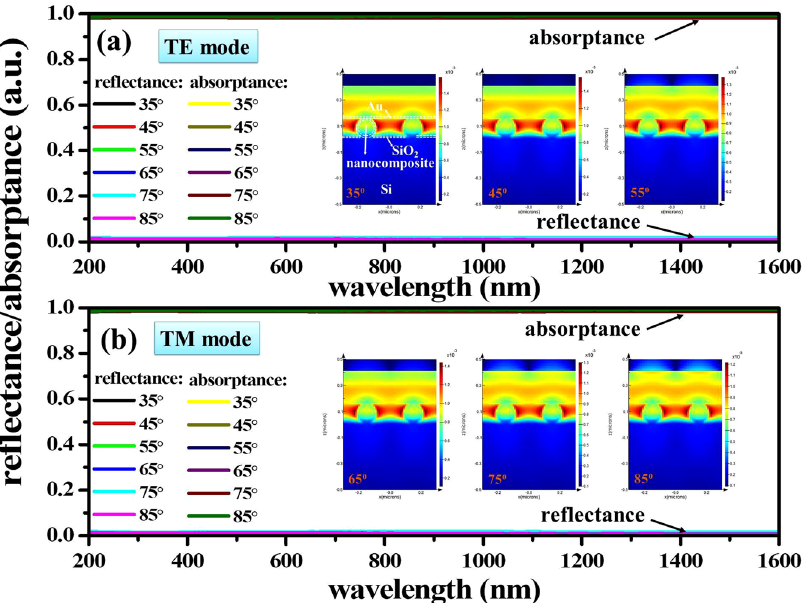
Figure 7. Simulated reflection and absorption spectra of proposed PMA at different polarization angle. The reflection and absorption spectra of PMA with pod-like nanostructures were simulated at ( a ) TE and ( b ) TM modes, respectively. The insert images of ( a ) and ( b ) are the electric field distributions from incident polarization angle from 35° to 85°,